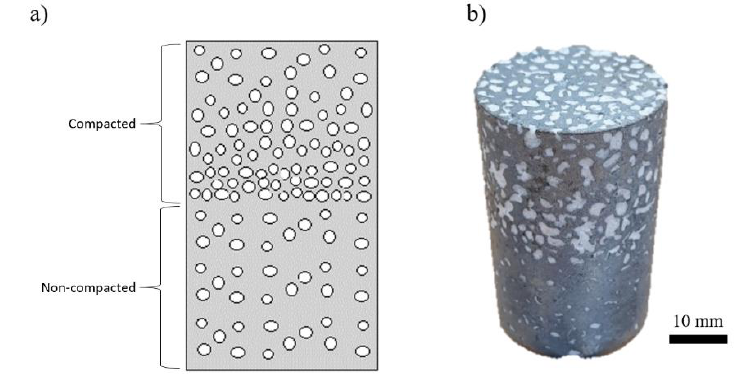
Figure 1. Functionally graded metallic syntactic foam (MSF): ( a ) schematics, and ( b ) completed sample.